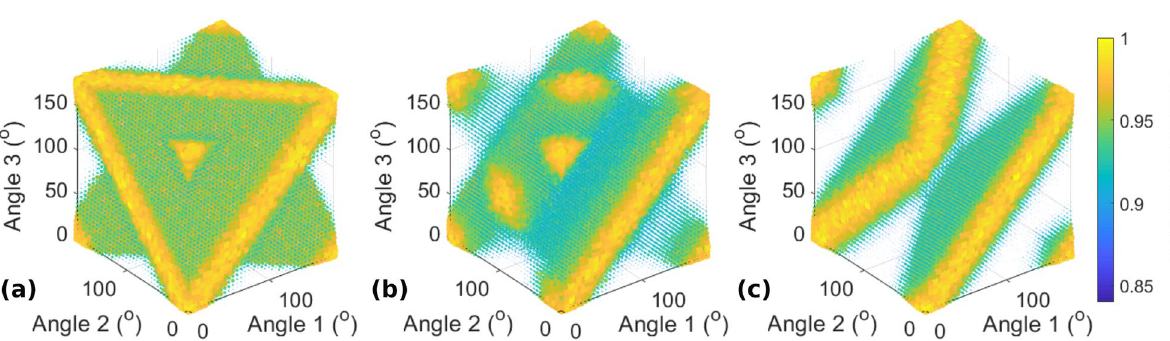
Figure 7. Pondered fairness I p for N waveplates and the fourth remains static at 0°. ( a )